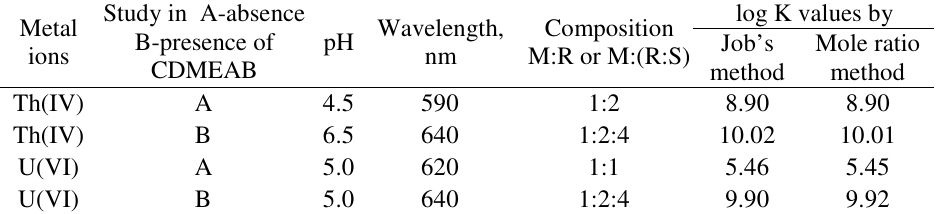
Table 1. Composition and log K values of thorium and uranyl chelates of CRAS in absence and presence of